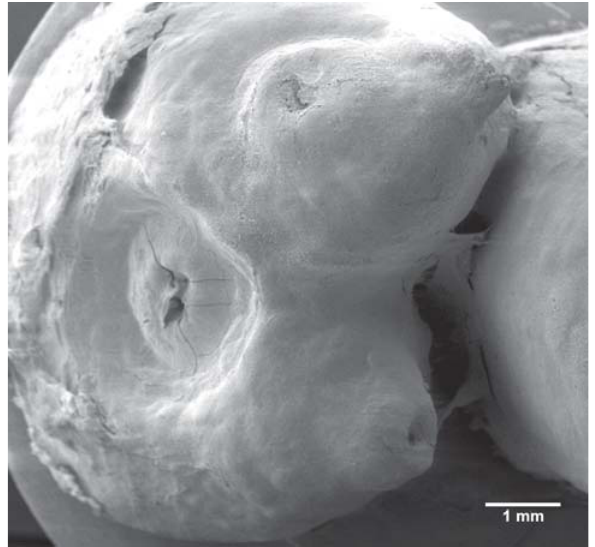
FIGURE 4- Circular cementum hyperplasia hypercementosis. Original magnification: ×15